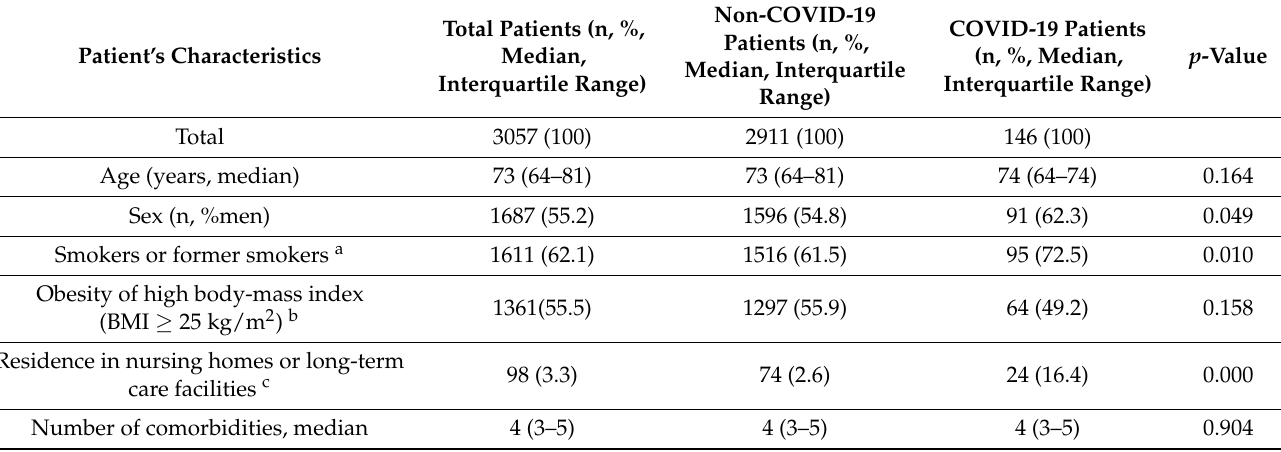
Table 1. Socio-demographic and baseline clinical characteristics of